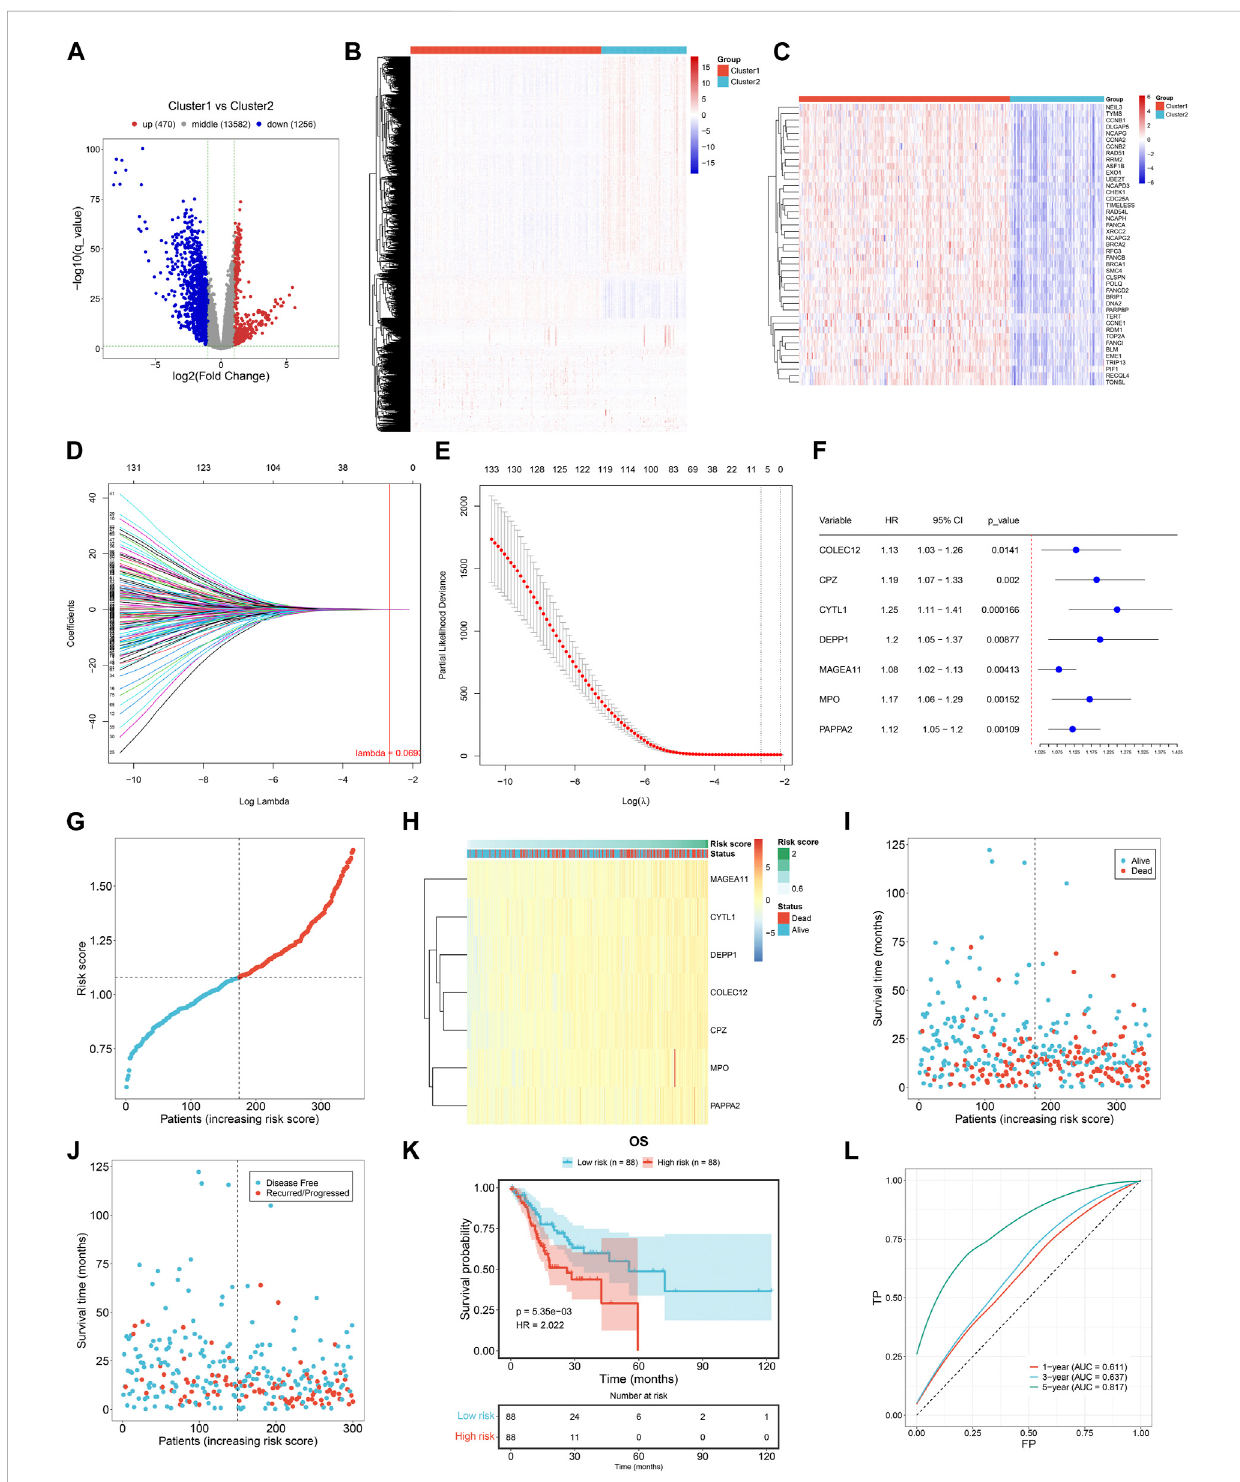
FIGURE 4 Generation of a DNA damage repair-relevant signature for predicting clinical outcomes of gastric cancer in the TCGA-STAD cohort. (A) Volcano diagramofthegeneswithdifferentialexpressionincluster1 versus cluster2baseduponthecriteriaof|FC| > 2andadjusted p < 0.05.Blue,downregulation; red, upregulation; grey, no signi fi cance. (B) Distribution of the transcription levels of above genes across the two DNA damage repair-based subtypes. Colors from blue to red denote low to high transcriptional levels. (C) Distribution of the transcription levels of DNA damage repair genes among them across the two subtypes. (D) LASSO coef fi cient pro fi ling of prognostic DNA damage repair-relevant genes. The vertical dotted line shows the optimal lambda value. (E) Partial likelihood deviance in the LASSO gene signature through ten-fold cross-validation. The vertical dotted lines denote the optimal values based upon the minimum and 1-SE criteria. (F) Forest plot of the relationships of transcriptional levels of prognostic DNA damage repair- relevantgeneswithgastriccancerOSthroughunivariatecoxregressionmethod. (G)